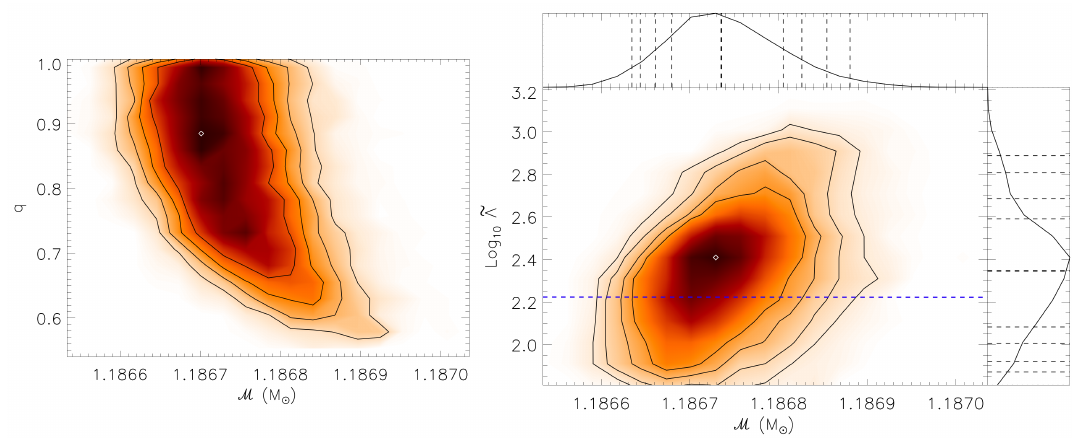
Figure 8. Neutron star parameters inferred for GW170817 [54], assuming that Λ 1 = Λ 2 q 6 . Contours refer to 68%, 80%, 90% and 95% confidence levels. Left panel : The binary chirp mass M and mass ratio q . Right panel : M and the binary deformability ˜ Λ . The blue dashed line shows the predicted minimum value from the unitary gas constraint [37]. Attached side panels show the integrated probability distributions over M or ˜ Λ ; dashed lines show where integrated probabilities reach 2.5%, 5%, 10%, 16%, 50%, 84%, 90%, 95% and 97.5%,